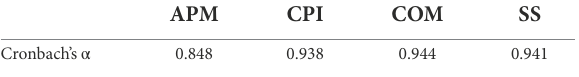
TABLE 8 Sub-dimensional Cronbach’s α coefficients.